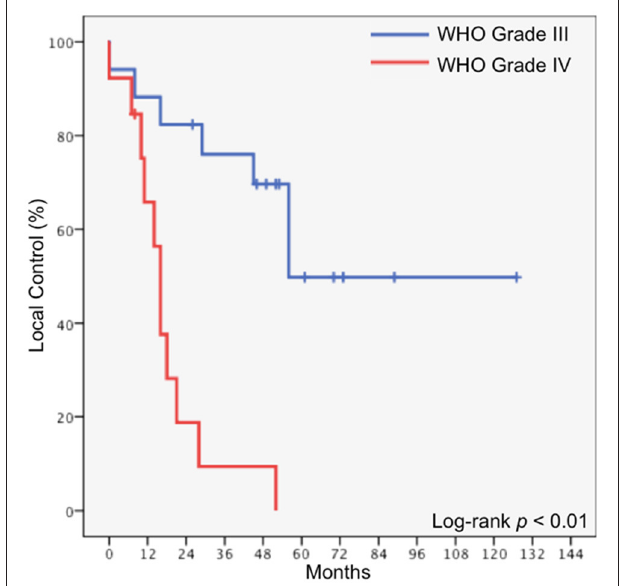
FIGURE 3 | Local control stratified by